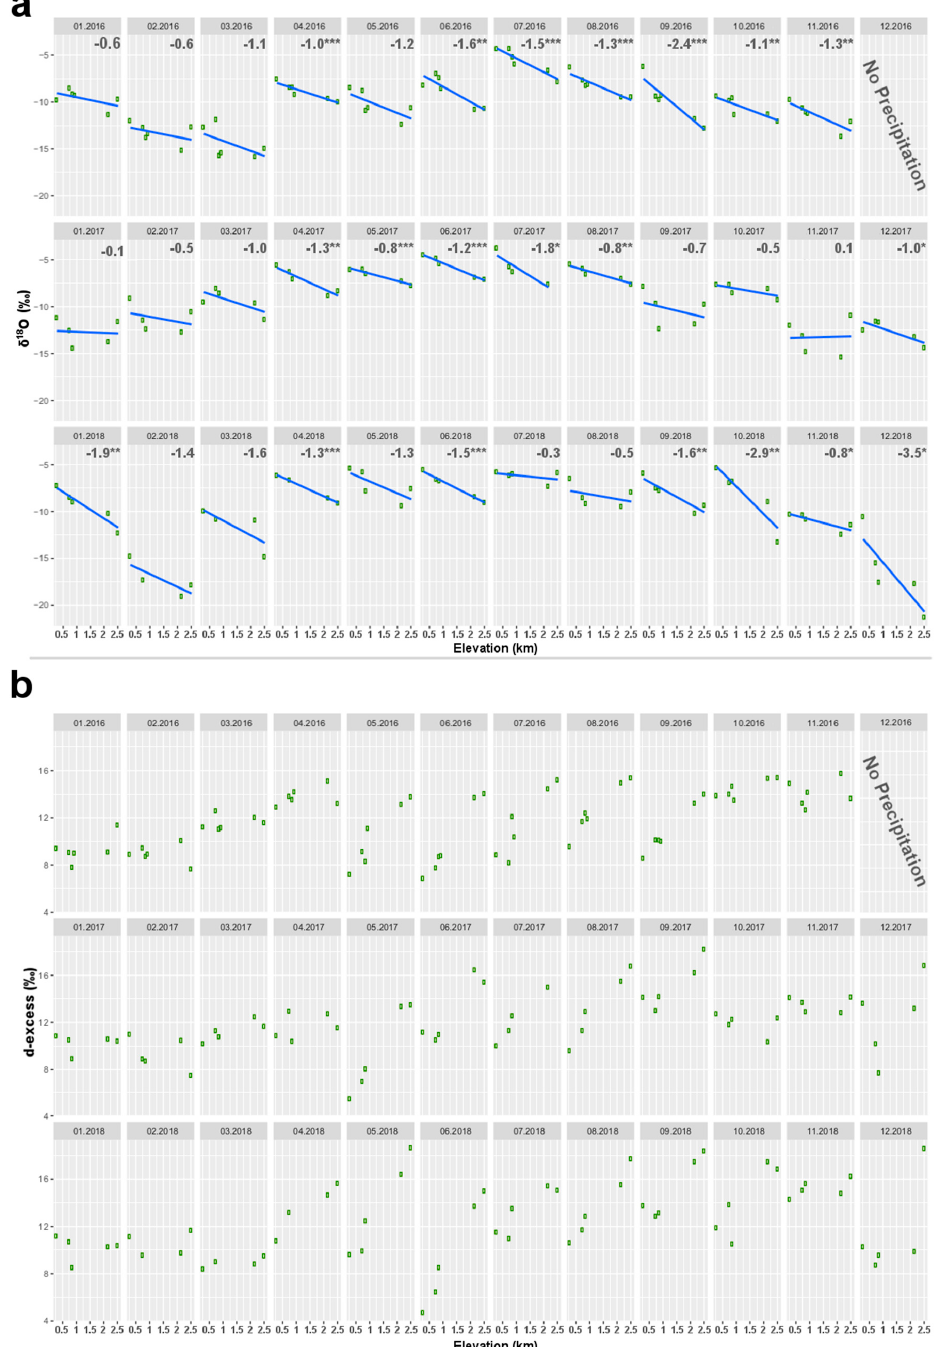
Figure 2. Stable isotope characteristics of monthly precipitation along a representative elevation transect in the Adriatic–Pannonian region: δ 18 O ( a ) and deuterium excess (d-excess) ( b ) vs. elevation. Best fit lines (blue) for precipitation δ 18 O data and elevation are plotted. The slope and significance of the linear fit are coded as α -values of 0.01, 0.05 or 0.1 and are marked with (***), (**) or (*), respectively.